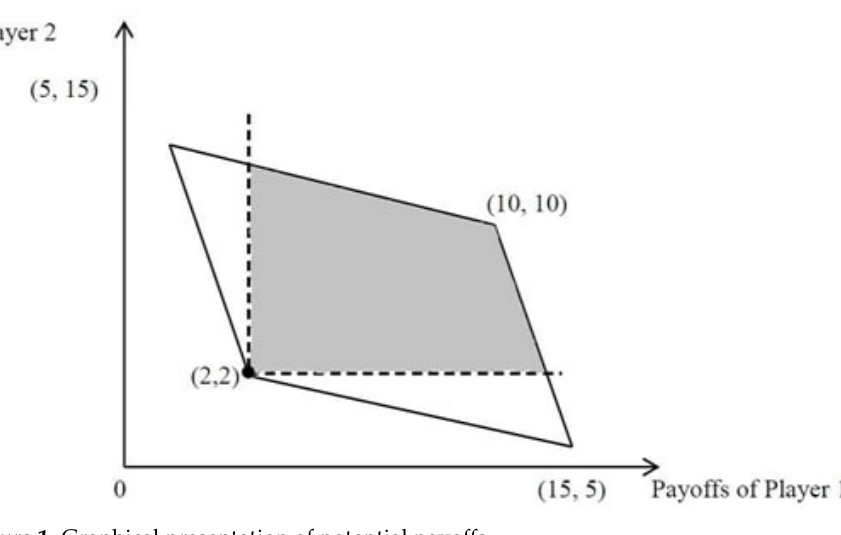
Figure 1. Graphical presentation of potential payoffs .